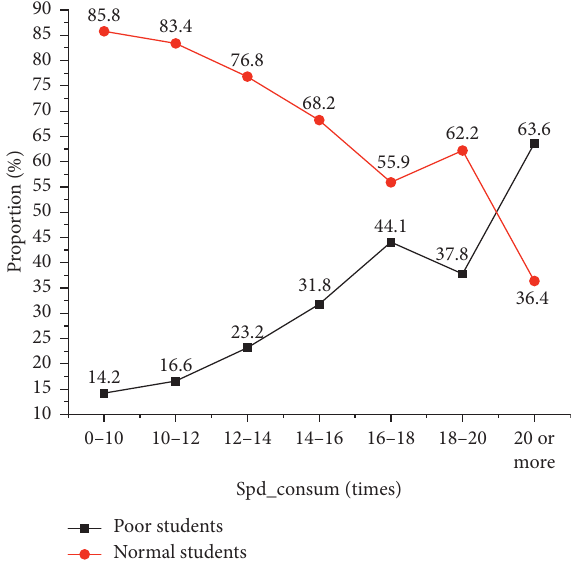
Figure 7: Proportion of poor students in different consumption